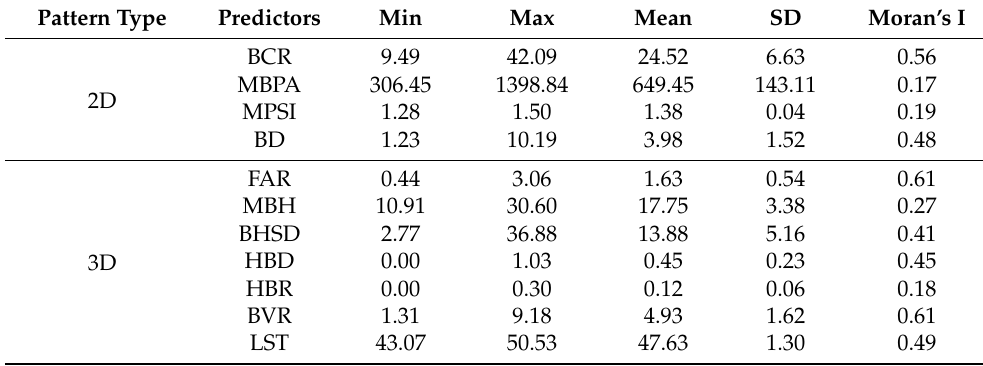
Figure 3. The spatial distribution patterns of buildings characteristics and LST. ( a ) Buildings; ( b ) Table 2. Descriptive statistics of 2D/3D building metrics and Table 2. Descriptive statistics of 2D/3D building metrics and LST.